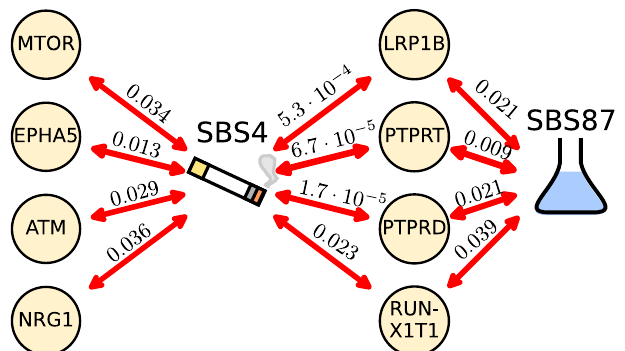
Figure 2. Signatures SBS4 and SBS87 correlate with mutations in genes canonically mutated in cancer (discovery set). Correlations were assessed using a Benjamini-Hochberg corrected Kendall τ (corrected p-values along the arrows) and the correlation strengths are indicated by the arrow line